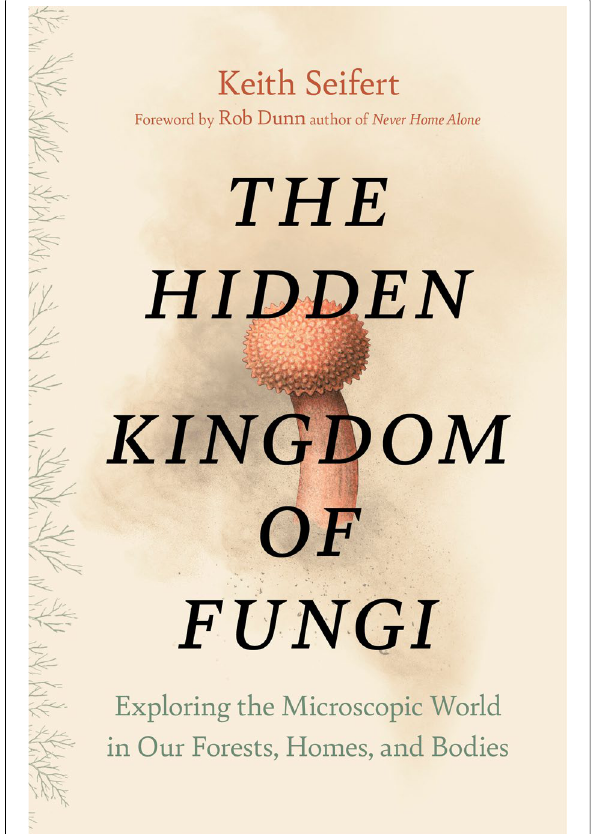
Fig. 36 The Hidden Kingdom of Fungi